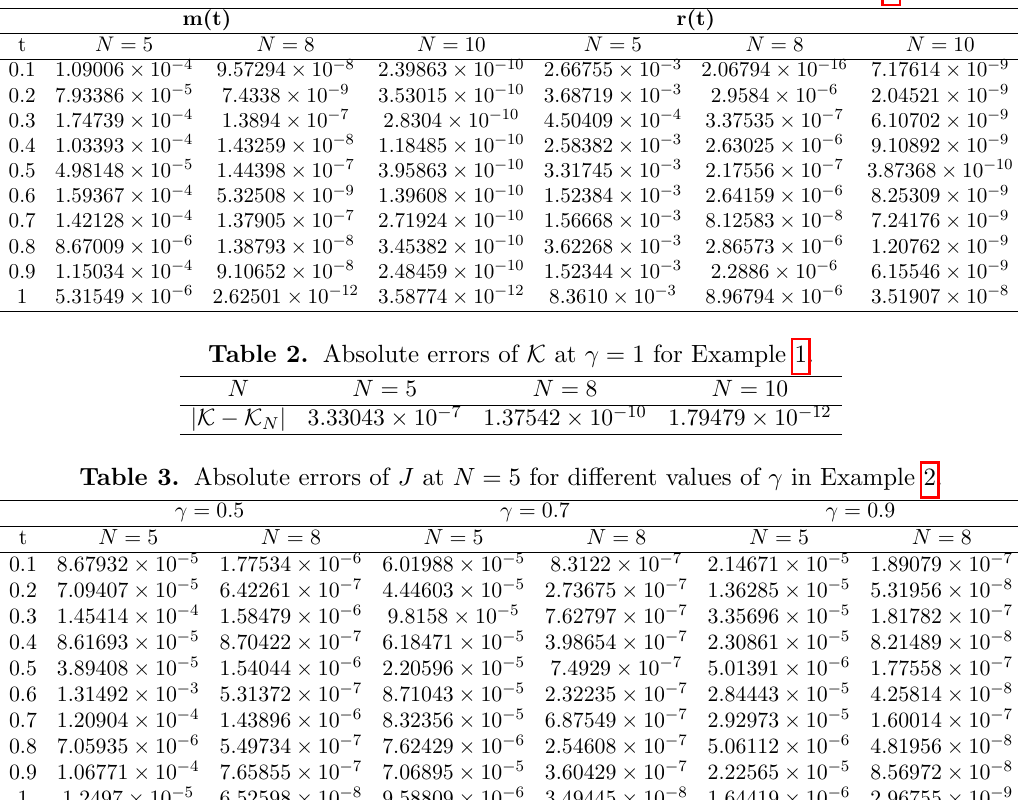
Table 1. The absolute errors of m ( t ) and r ( t ) for γ = 1 for Example 1.